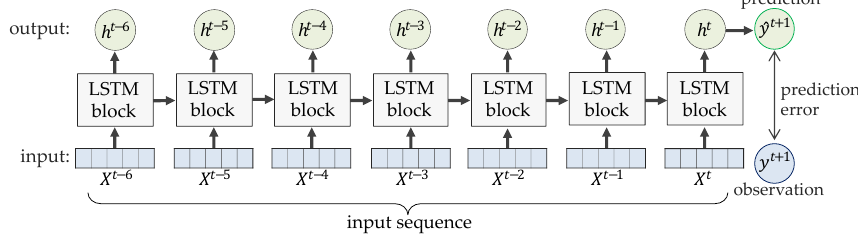
Figure 7. Input sequence processing for forecasting the next day peak load ( ˆ y t + 1